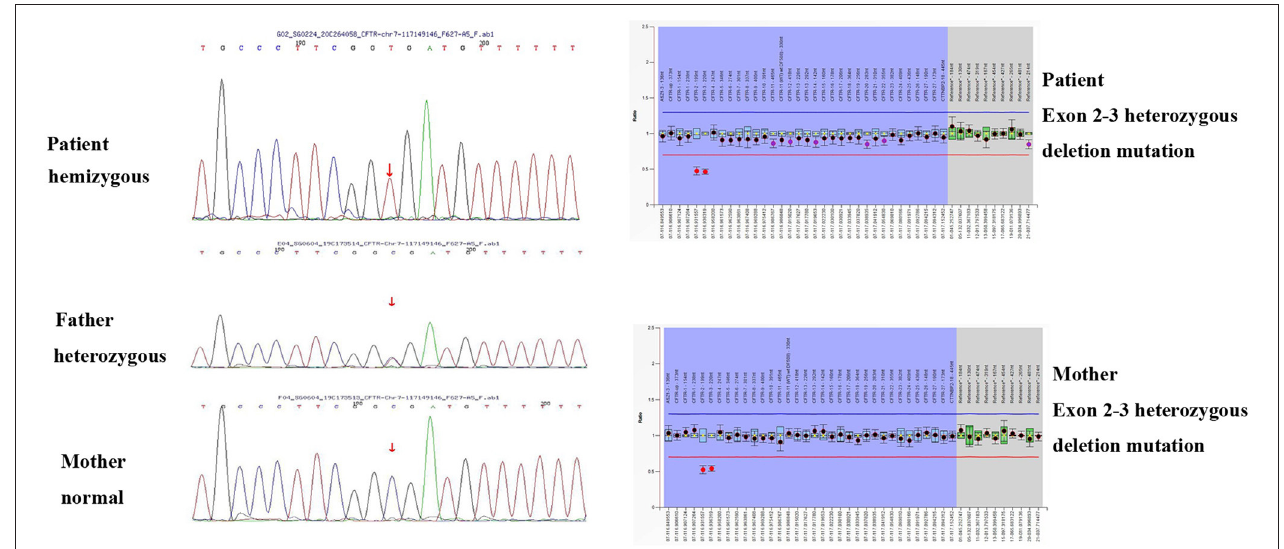
FIGURE 1 | Genetic testing results of the infant and the parents.